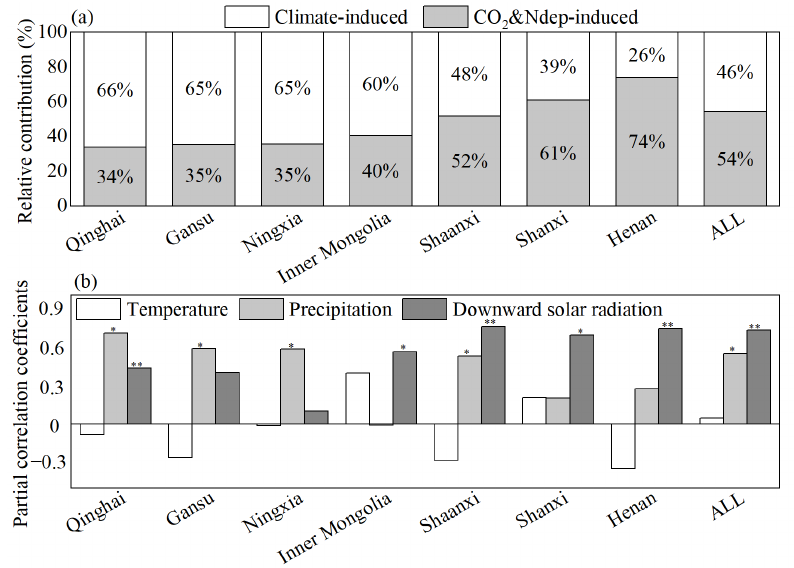
Figure 6. ( a ) Relative importance of climate change and CO 2 fertilization to environmental-induced LAI on the Loess Plateau from 2000 to 2019. ( b ) Partial correlation coefficients between climate- induced LAI and climate factors. * = P < 0.05 and ** = P < 0.01.